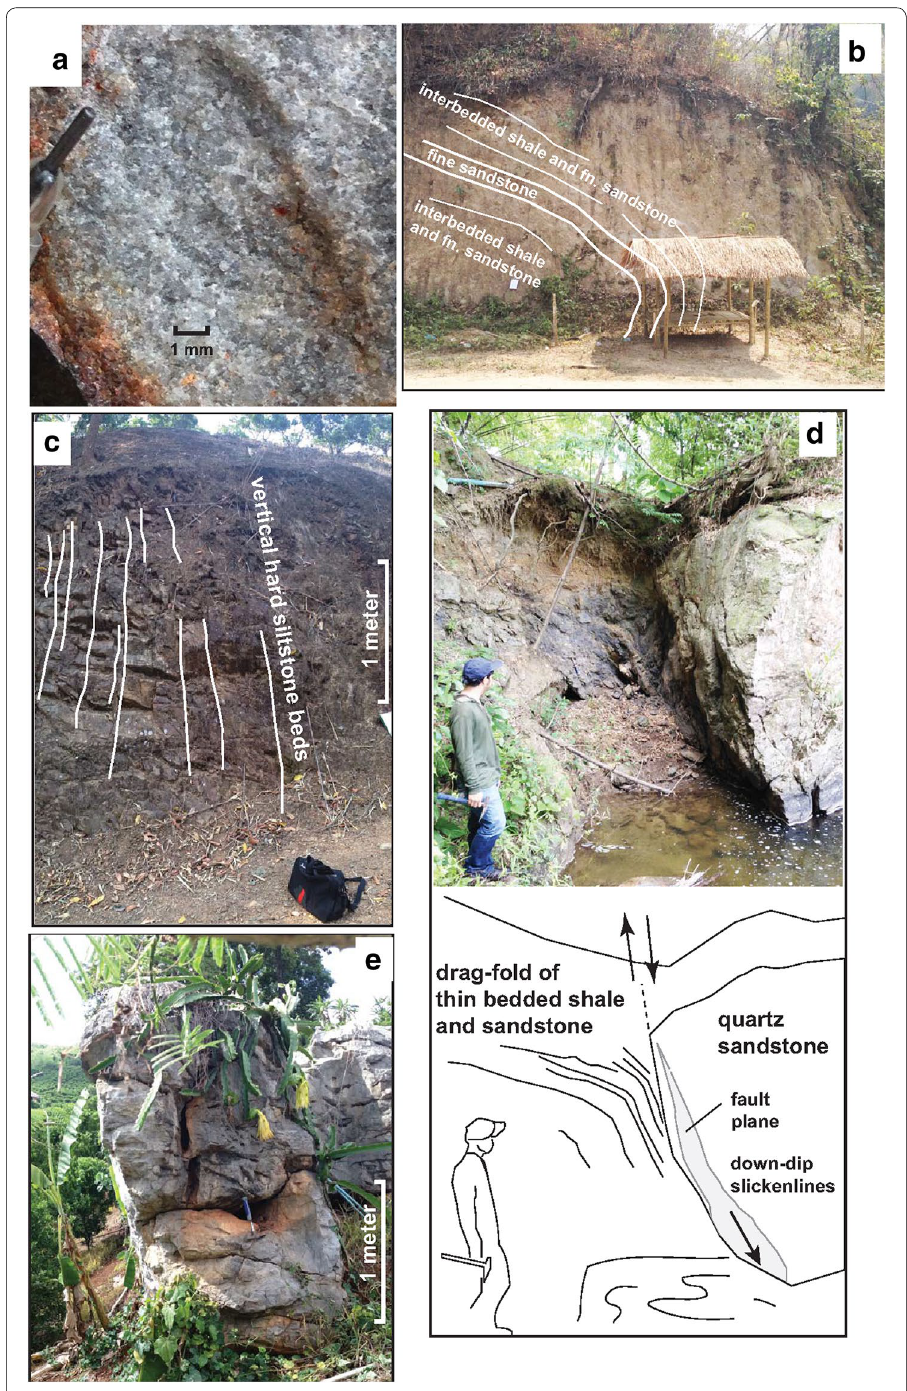
Fig. 12 a Close-up photo of orthoquartzite (quartz arenite) showing interlocking grains of ~ 0.6 mm. b Outcrop of interbedded sandstone and hard shale, fold axis plunges 21° in the 120°direction, upper limb beds dip 46° SW, and strike 102° (outcrop face oriented 068°, located at 518940E, 2208249N). c Outcrop of medium-bedded hard siltstone, near vertical dip, 122° strike, bedding shown by white lines (located at 518173E, 2208558N). d Outcrop of fault in the bed of the Nam Mae Chai River at 516585E, 2207275N), show- ing normal fault striking 020° dip 80°NW, with drag on the thin-bedded shale and sandstone. Photo is looking south. e Outcrop of gray limestone at 514850E,